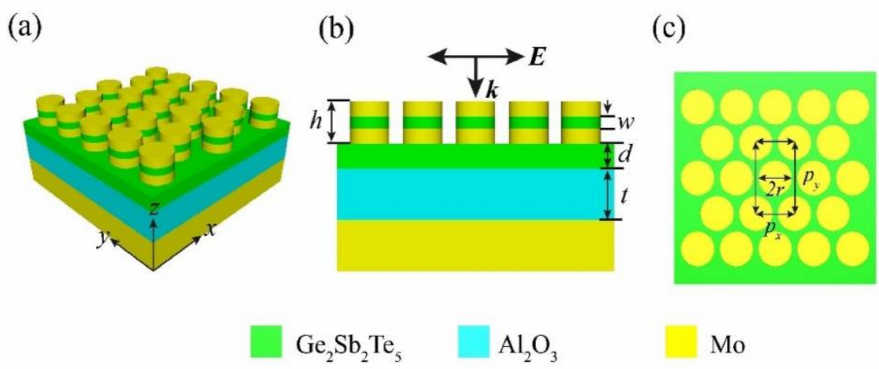
Figure 1. ( a ) Schematic diagram and ( b ) a cross-sectional view of the Mo-GST-Mo nanodisk arrays. ( c ) A schematic top view of the entire structure. The overall height of the Mo-GST-Mo nanodisk is h , the thickness of the GST interspersed in the middle is w , and the heights of the underlying GST film and Al 2 O 3 layer are d and t , respectively. r represents the radius of the nanodisk array. Separately marked are the periods of the arrays in the x and y directions as p x and p y .